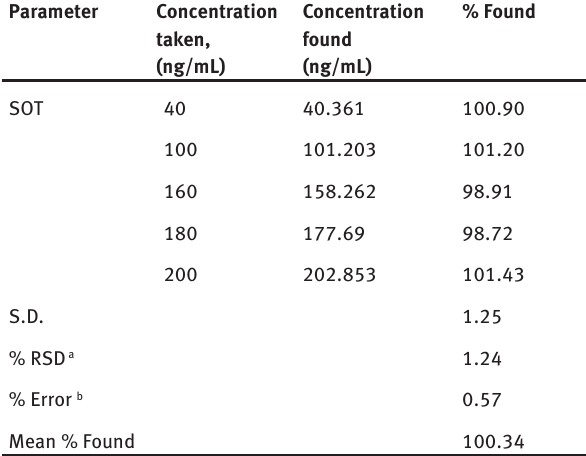
Figure 6: Emission spectra of SOT in spiked human plasma where (a) plasma blank and (b, c, d, e, f and g) SOT in spiked human plasma in a concentration of 40, 100, 120, 160, 180 and 200 ng/mL.